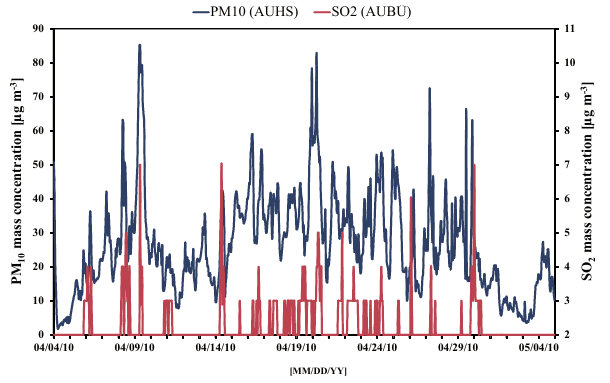
Fig. 2. Time series section of normalized hourly average PM 10 contribution of long range transported dust factor at the University of Applied Sciences in Augsburg, Germany (average of all con- tributions for each factor is 1 for the total time period April to May 2010). The percentage of the particle mass size distribution is shown in the